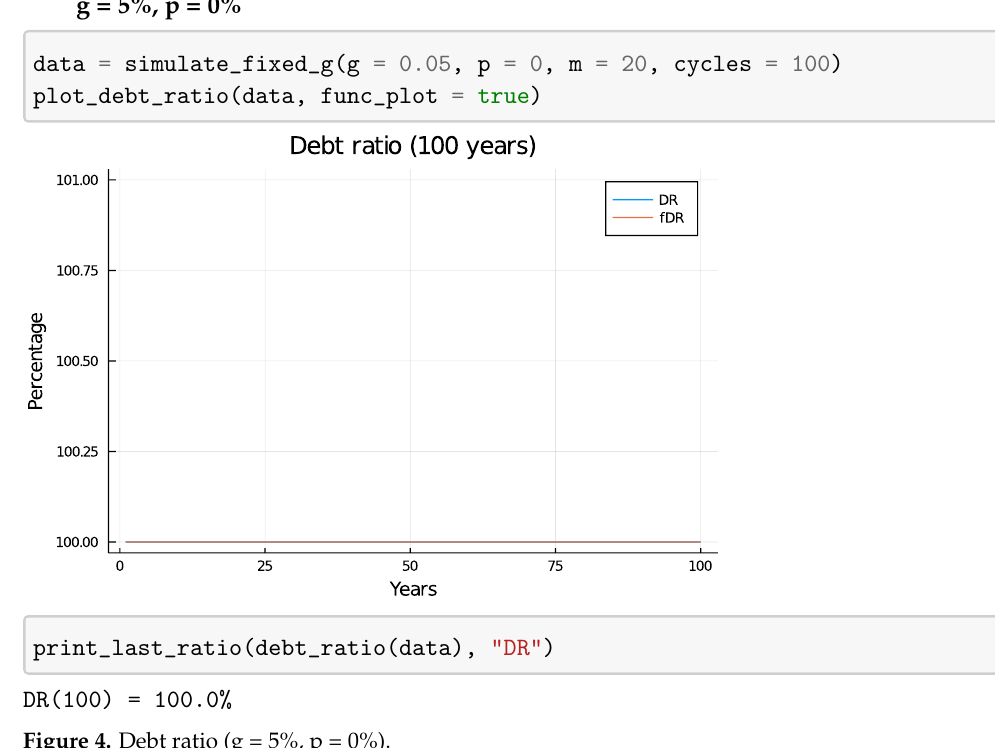
Figure 4. Debt ratio (g = 5%, p = 0%).